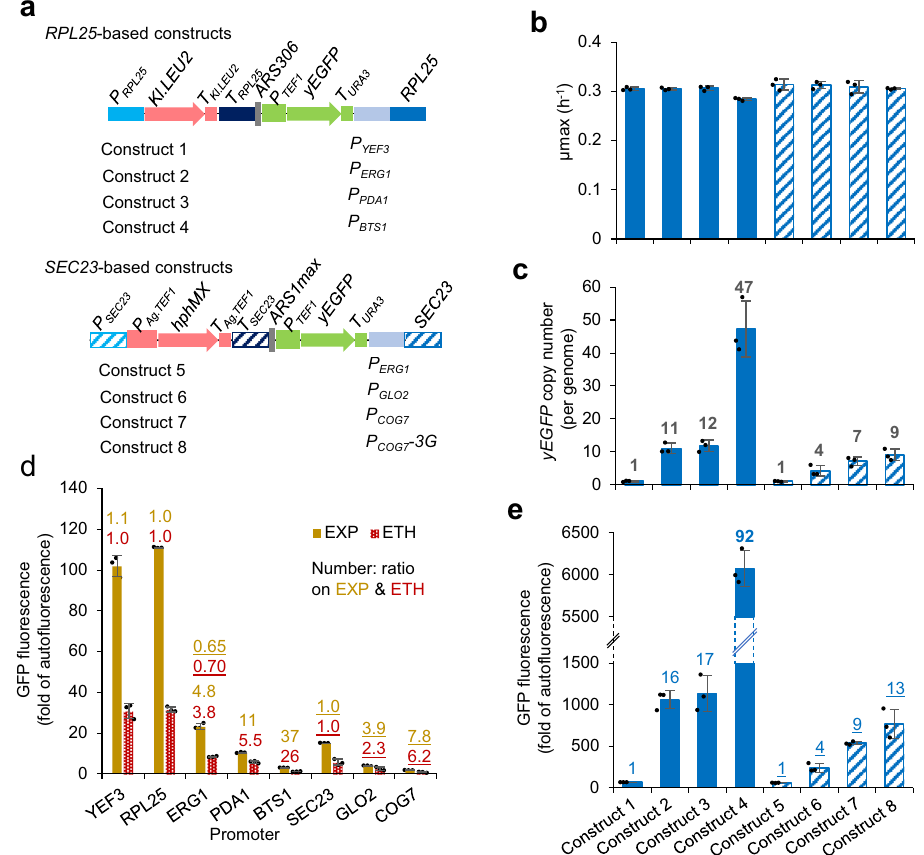
Fig. 2 Design and characterisation of gene ampli fi cation constructs for haploinsuf fi cient target genes RPL25 or SEC23 . a Schematic of gene ampli fi cation constructs. b , c , e Maximum growth rate, yEGFP (yeast-enhanced green fl uorescent protein) gene copy number, and yEGFP fl uorescence in strains transformed with the constructs in a . Strains were selected by brightness of yEGFP fl uorescence (Supplementary Fig. 1). d Promoter characterisation using yEGFP as the reporter in the cells at the exponential growth phase (EXP) and the post-diauxic-shift growth phase (ETH) when ethanol was used as the carbon source. Yeast cells were grown in microplates in d and in fl asks in b , c , e . yEGFP fl uorescence is expressed as percentage of exponential-phase auto- fl uorescence of the reference strain. The numbers were calculated by dividing the mean value for RPL25 or SEC23 (underlined) by the mean value. Mean values± standard deviations are shown ( N = 3 independent biological replicates). Source data are provided as a Source Data fi